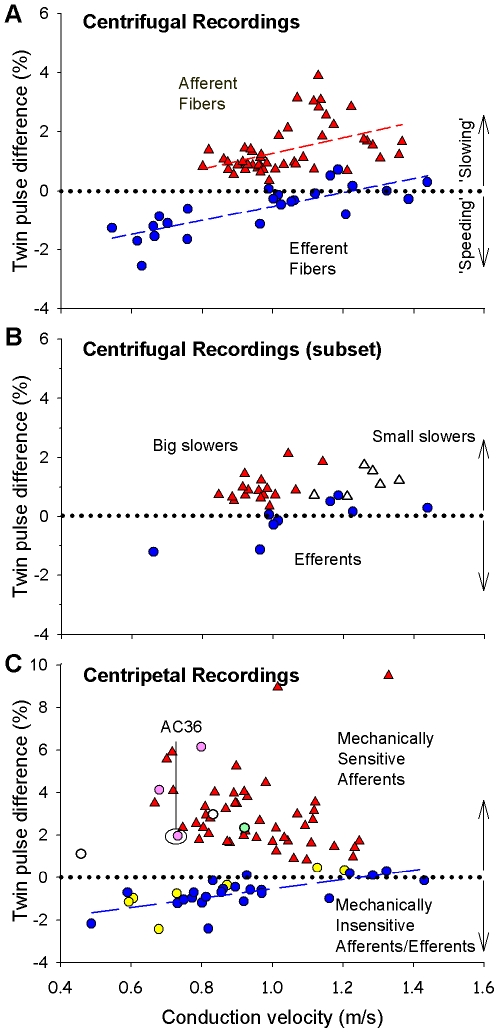
Twin pulse stimulation reveals two distinct populations.
A) Afferent and efferent fibers have different twin pulse responses. Following electrical twin pulses (50–70 ms ISI) at the sciatic nerve, all afferent fibers (red triangles, n = 48) exhibited an increase in conduction latency for the second action potential (AP). In sympathetic efferent fibers (blue circles, n = 24) the change in conduction latency was dependent on the initial conduction velocity (R2  = 0.63); slower fibers showed a decrease in latency (i.e., speeding of conduction) whereas faster fibers demonstrated a modest increase in latency. The data clusters are almost non-overlapping. A negative value for twin pulse latency difference means that the second AP has a shorter latency than the first AP. B) The initial twin pulse response does not predict the amount of activity-dependent slowing in the afferents. The “big slowers” and “small slowers” in response to the repeated stimulation paradigm (Fig. 4) have a similar twin pulse difference but different conduction velocities. The data are from all fibers in which the activity-dependent slowing protocol (2 Hz, 3 min) was performed. C) Mechanically-sensitive and -insensitive fibers respond differently to twin pulse stimulation. In a separate series of experiments, the response to electrical stimulation at peripheral terminals was examined. Mechanically sensitive nociceptors (triangles) exhibited twin pulse slowing. Most mechanically-insensitive fibers behaved like sympathetic fibers (blue circles) and exhibited twin pulse speeding. In ten mechanically-insensitive fibers capsaicin and/or histamine were injected into the electrical receptive field; three responded (pink circles) and were likely afferents; seven were unresponsive (yellow circles) and are presumed sympathetic fibers. One mechanically-insensitive fiber (green circle) not tested with chemicals behaved like an afferent to the repeated twin pulse paradigm (see Fig. 6). Two mechanically-insensitive fibers (open circles) not tested with chemicals or repeated twin-pulses exhibited twin-pulse slowing and may therefore be afferents.